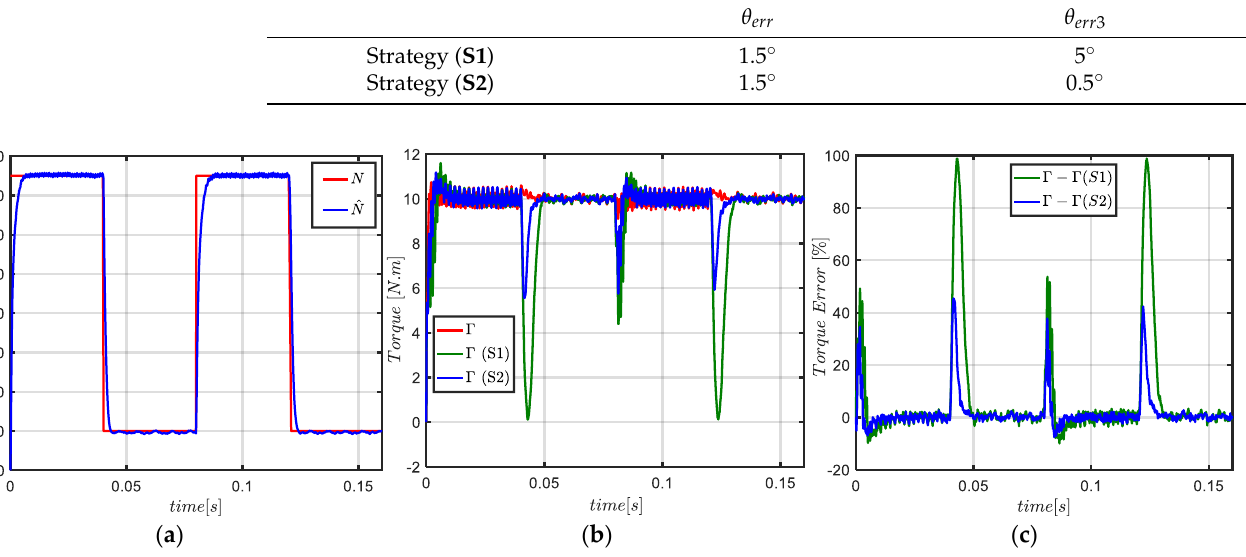
Figure 21. Simulation waveforms at 78 rad/s of position errors resulting from ( S1 ) and ( S2 ): ( a ) error on the angle required to control MM, ( b ) error on the angle required to control SM. Table 4. Resulting position error (electrical angle) from strategies ( S1 ) and ( S2 ).